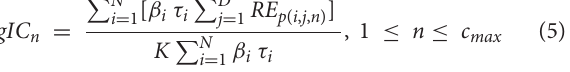
on inter-subject consistency representing the contribution